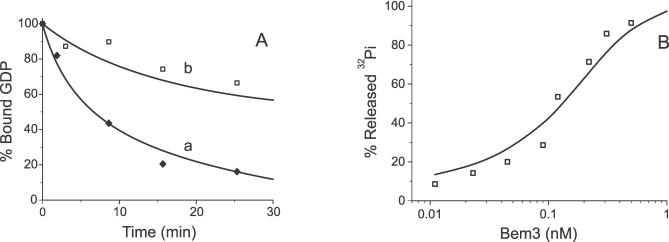
Simulation of the Yeast cdc42p Cycling In Vitro(A) Kinetics of GDP dissociation from [3H]GDP-bound cdc42p after mixing with GTP. Comparison of the model simulations and experimental results [59] is shown as groups a and b for the reactions with and without GEF cdc24p, respectively. Concentrations of cdc42p, cdc24p, and GTP were 90 μM, 28 μM, and 100μM.(B) Simulation of GAP-stimulated GTP hydrolysis by cdc42p. Experimental data are for the yeast GAP Bem3 [60]. GTP hydrolysis was essayed by measuring phosphate (Pi) release over 5 min. Initial concentration of [γ-32P]GTP-bound cdc42p was 0.1 μM. Simulation results are shown by solid lines.